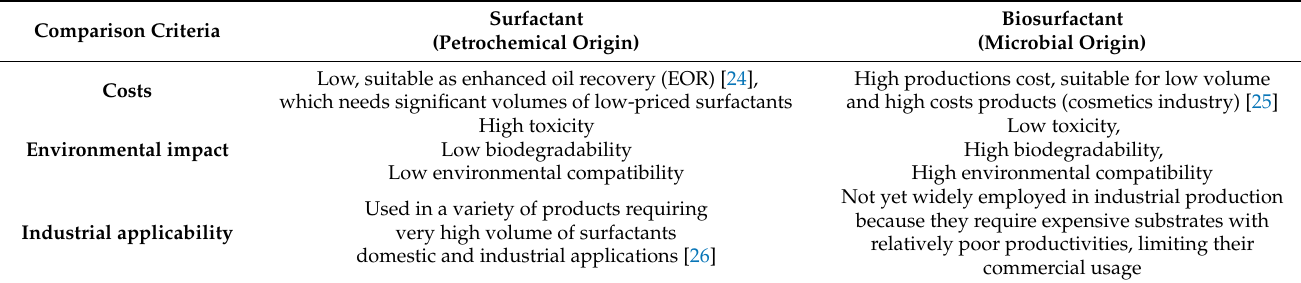
Figure 1. Main types of biosurfactants by molecular mass. Table 1. Differences between biosurfactants and